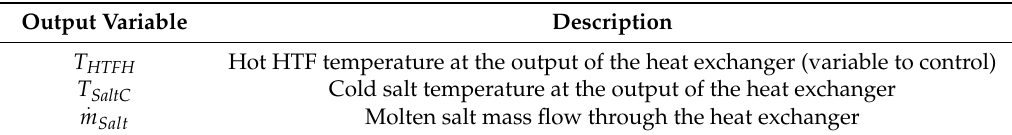
Table 3. TES Discharging Output Variables.